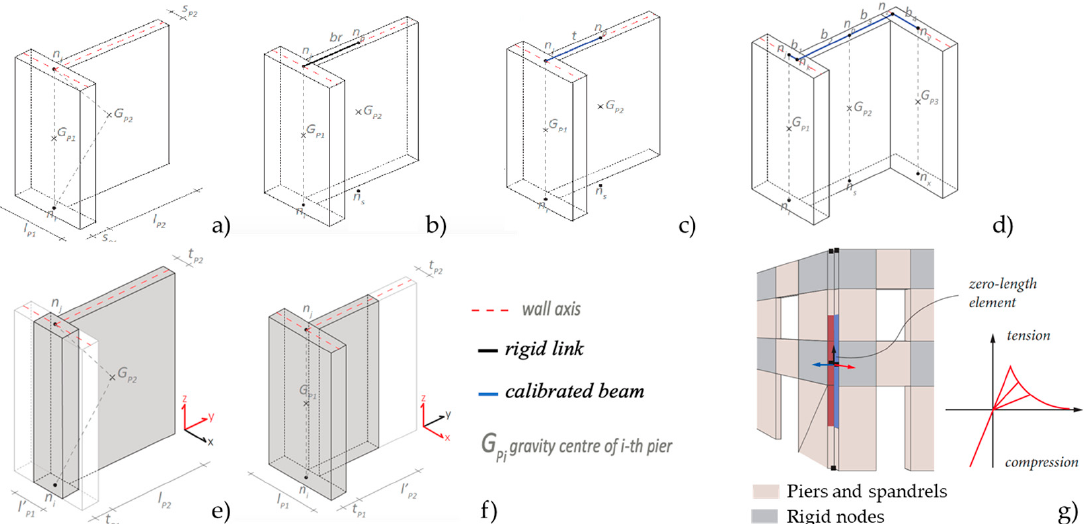
Figure 2. Alternative modeling options for simulating the wall-to-wall connection if equivalent frame models are used (adapted from [8]): ( a ) perfect kinematic coupling with a rigid offset; ( b ) rigid link; ( c ) and ( d ) equivalent elastic beams; ( e ) and ( f ) modeling of effective width the collaborating part of the flange; ( g ) zero-length elements.